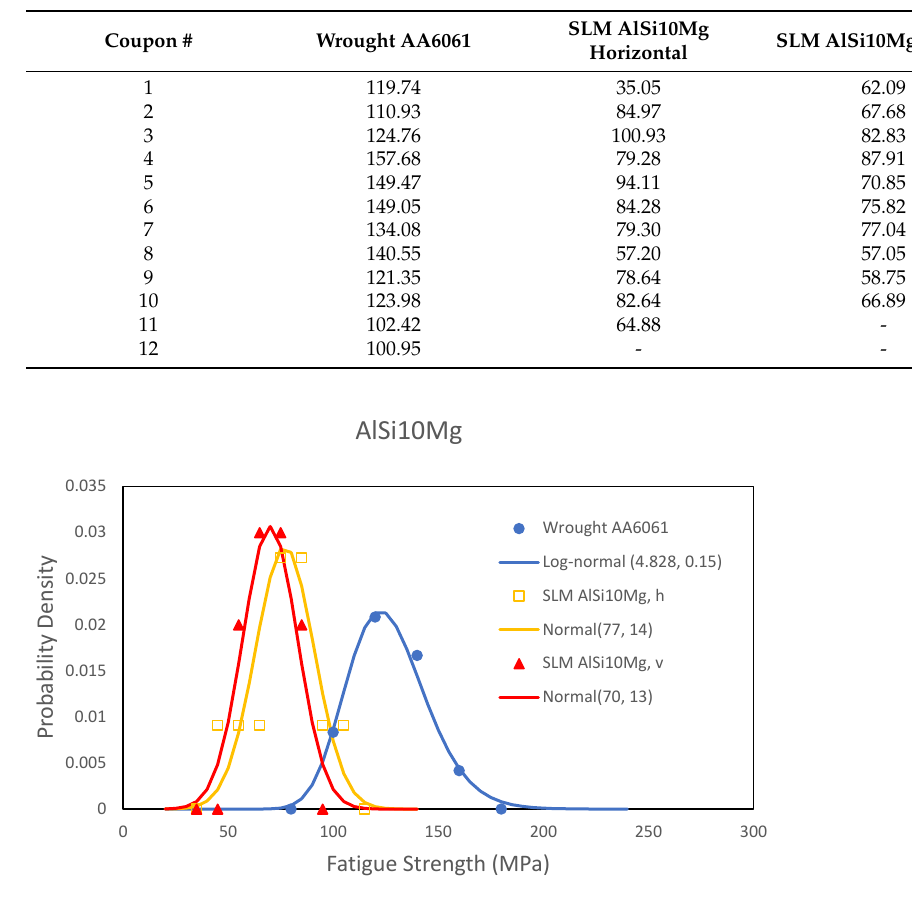
Figure 7. Distributions of fatigue endurance limit in wrought Al 6061 and SLM AlSi10Mg materials.